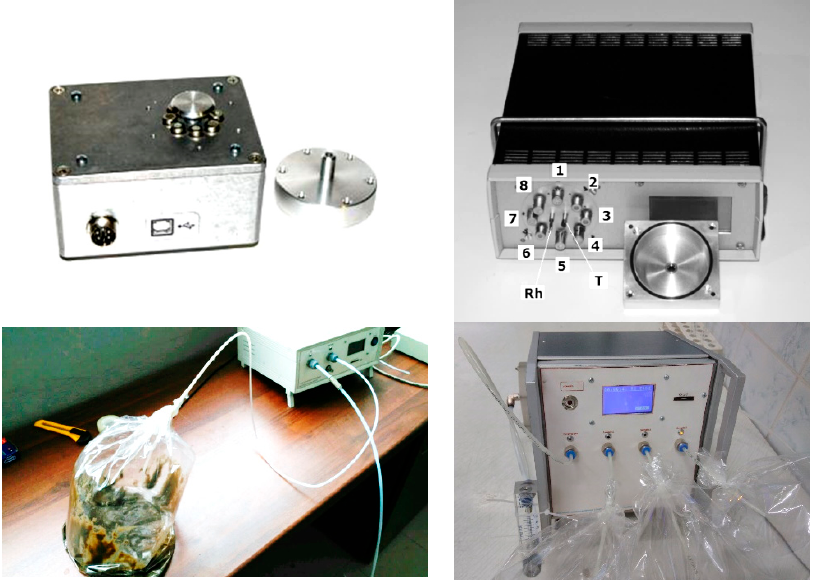
Figure 4. Di ff erent versions of e-noses developed at Lublin University of Technology: Top left shows laboratory version 7 × MOS (Metal Oxide Semiconductor) with undercover sensor chamber; top right is the portable device 8 × MOS undercover sensor chamber (1-8 Figaro gas sensors and temperature and relative humidity sensors); bottom left is laboratory version 16 × MOS with 2 switching inlets (flushing air and sample); bottom right is laboratory version 17 × MOS with 4 multiplexed inlets (flushing air and 3 samples).